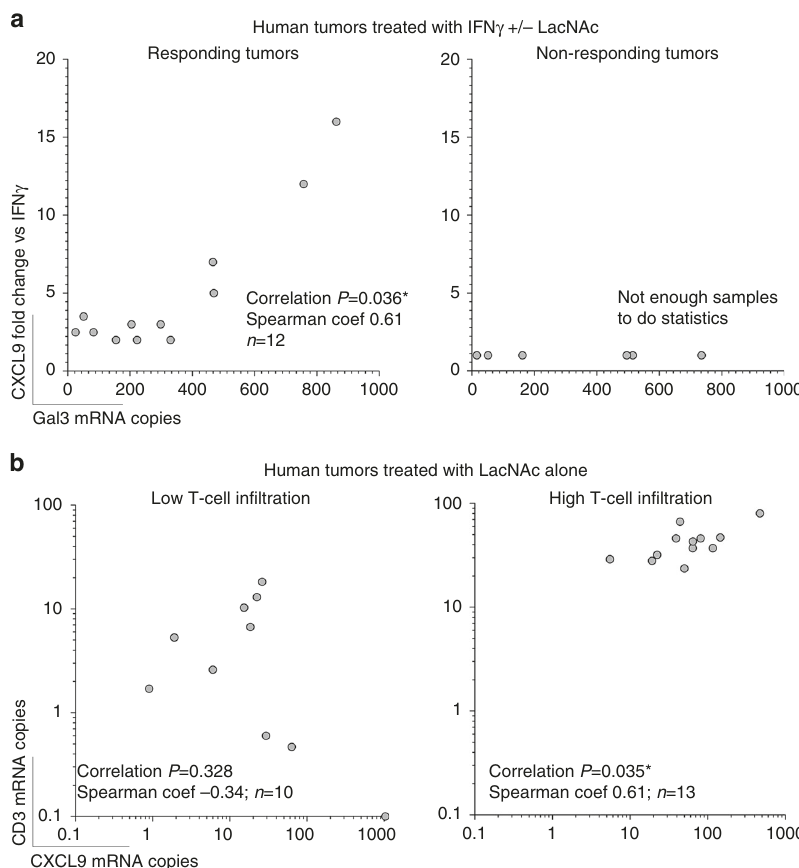
Fig. 4 Correlation between CXCL9 induction and T-cell in fi ltration or galectin-3 expression in human tumor biopsies treated ex vivo with galectin antagonists. Samples corresponding to those of Table 1. Correlation probabilities and non-parametric correlation coef fi cients are shown in each graph. a Correlation between CXCL9 induction (fold change induction in samples treated with IFN γ and LacNAc versus their corresponding samples treated with IFN γ alone) and galectin-3 expression in responding or non-responding tumors (having de fi ned responding tumors such as those were CXCL9 fold change was at least two). b Correlation between CXCL9 and CD3 expressions in tumors treated with LacNAc alone and strati fi ed depending on their T-cell in fi ltration. Tumors were considered as highly in fi ltrated if their CD3 expression was bigger than the average CD3 expression of all the tumor